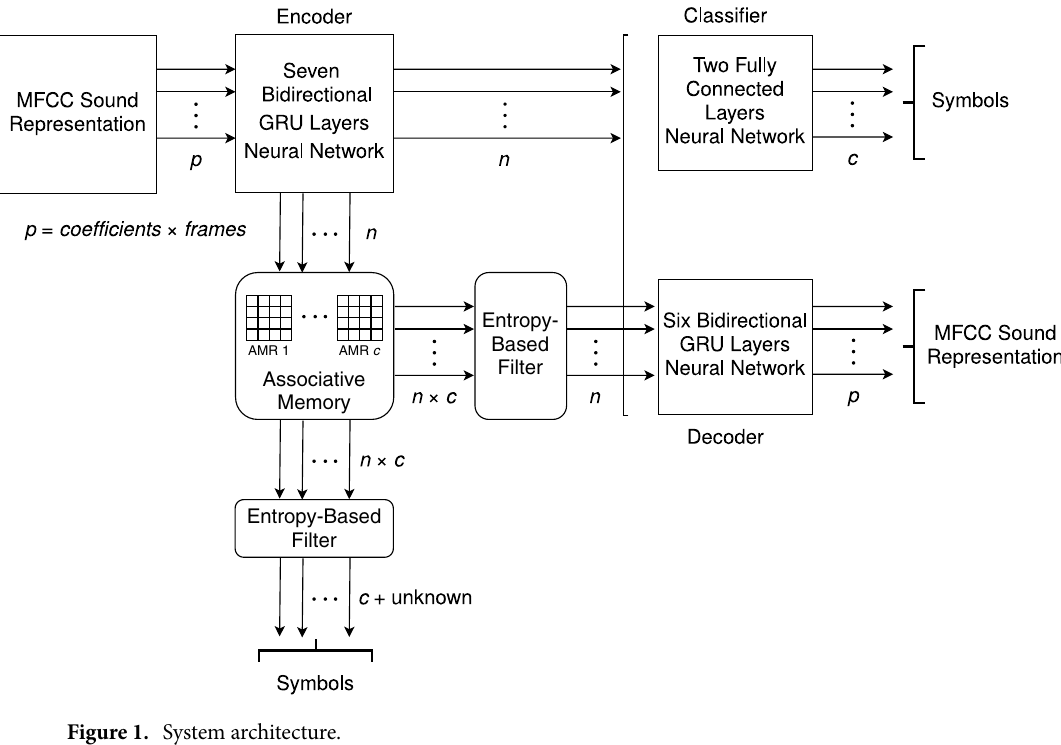
Figure 1. System